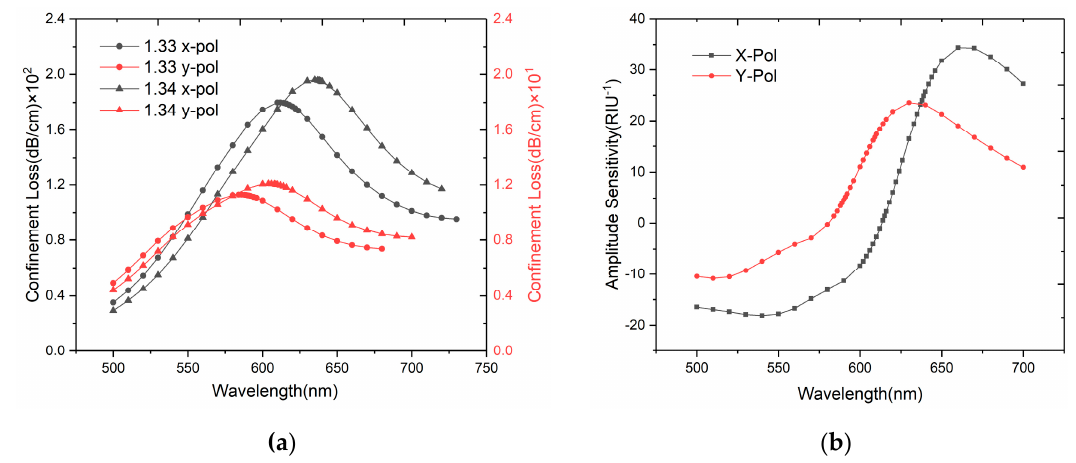
Figure 3. ( a ) Loss spectra of x-polarized and y-polarized with analyte RI = 1.33 and 1.34; ( b ) Amplitude sensitivity of x-polarized and y-polarized.